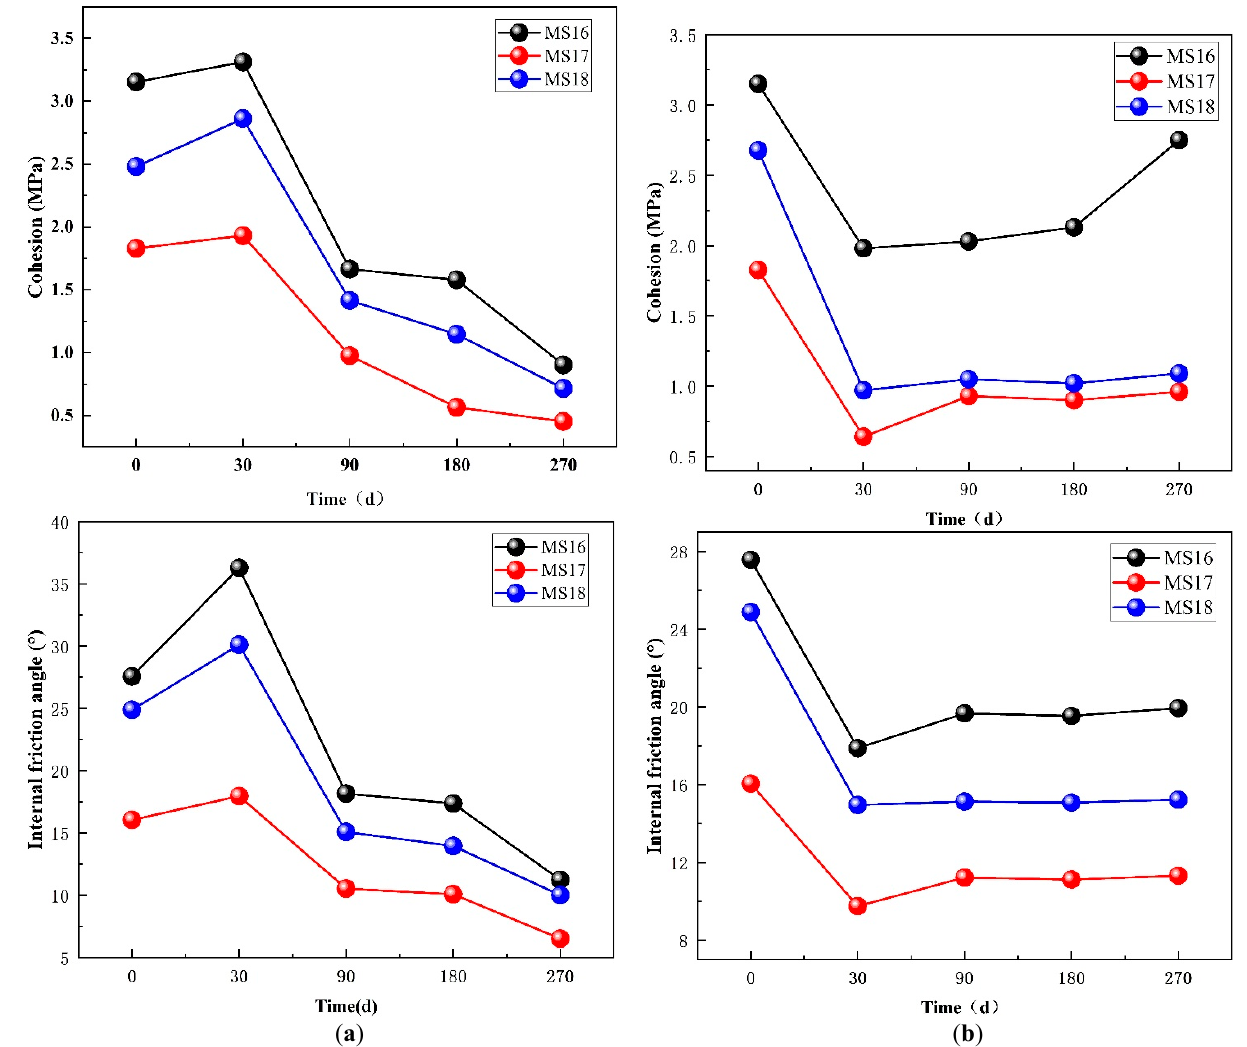
Figure 5. The internal friction angle and cohesion of MS16–MS18 samples exposed to air or immersed in water. ( a ) Exposed to air. ( b ) Immersed in water.